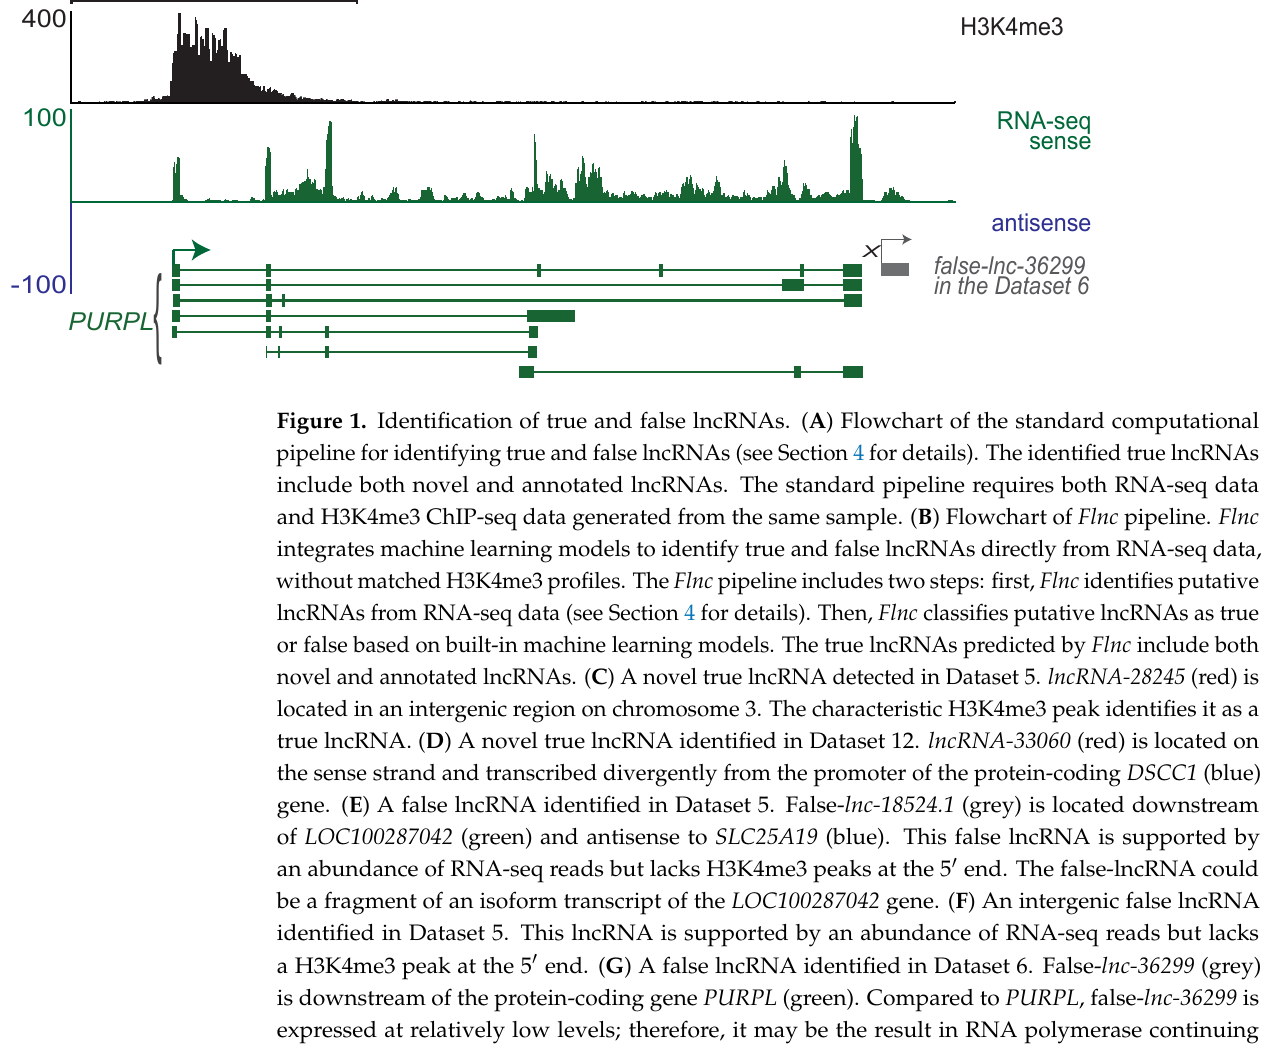
beyond the polyA signal sequences when transcribing PURPL (transcriptional noise)